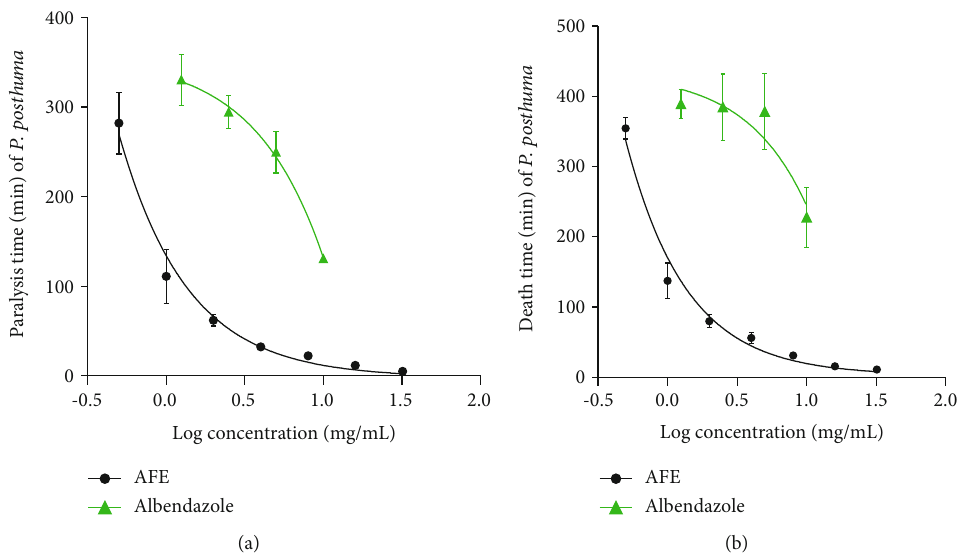
Figure 1: E ff ect of AFE and albendazole on paralysis and death of P. posthuma. (a) Paralysis time. (b) Death time. No paralysis and death was observed after the maximum time of exposure (8 hours) in the negative control group (Ringer ’ s lactate solution). AFE: ethanol stem bark extract of A. ferruginea .